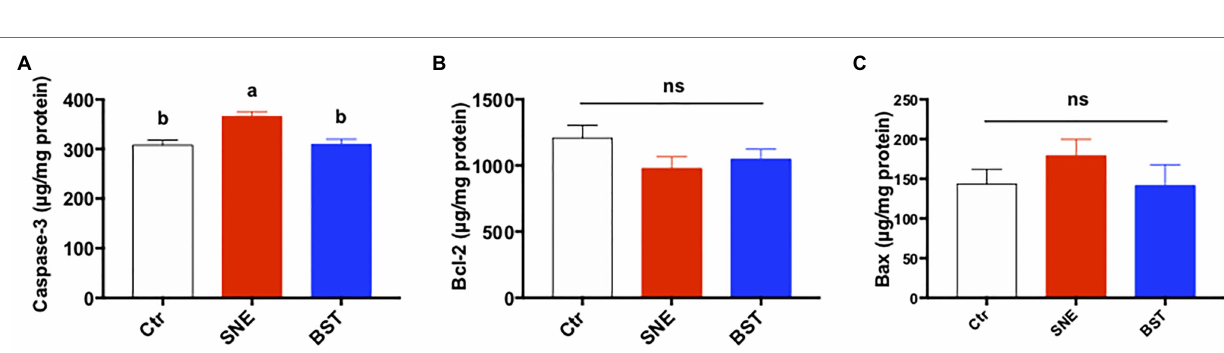
FIGURE 4 | Levels of apoptosis-related proteins [caspase-3 (A) , bcl2 (B) , and bax (C) ] in the jejunum. Bars with different letters significantly differ on the basis of Turkey’s multiple range tests ( p < 0.05). Data are presented as mean ± SEM ( n = 8). Ctr group, basal diet in control group; SNE group, basal diet + SNE (20-fold dose